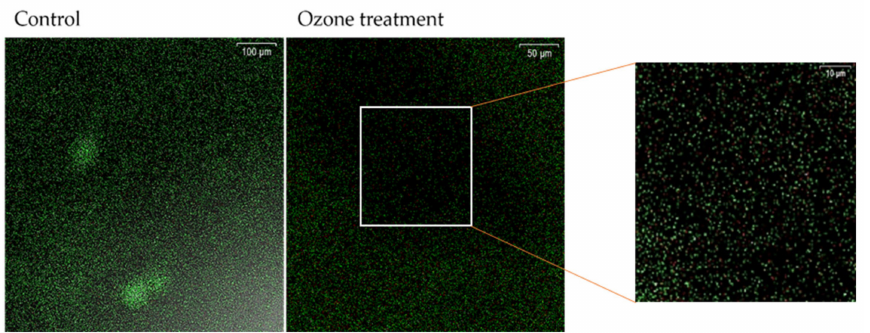
Figure 9. Viability of the representative strain K. pneumoniae NCTC 13442 cells in biofilm. Viability of nontreated control group, and 25 ppm of ozone/1h treated group using Dead/Live staining. Green fluorescence is representing viable cells with intact membrane, and red fluorescence indicates dead cells with permeable